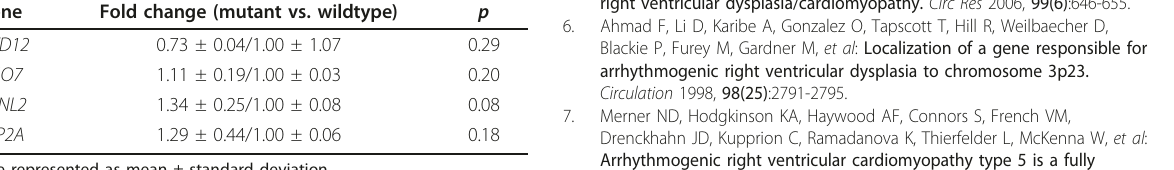
Table 2 mRNA expression in selected genes on chromosome 13 following transfection with either wildtype or mutant TMEM43 plasmid Gene Fold change (mutant vs. wildtype)